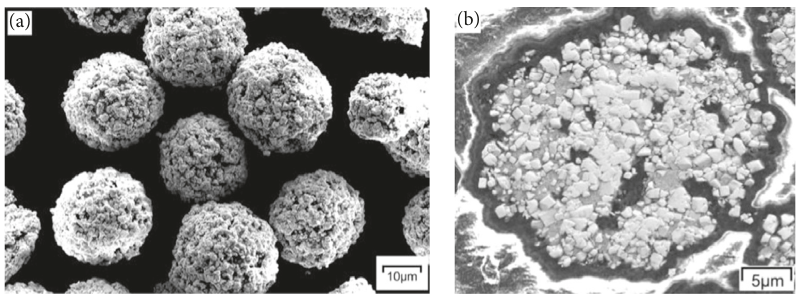
Figure 18: Morphology of WC-Co powder: (a) surface morphology and (b) cross-sectional view [84].